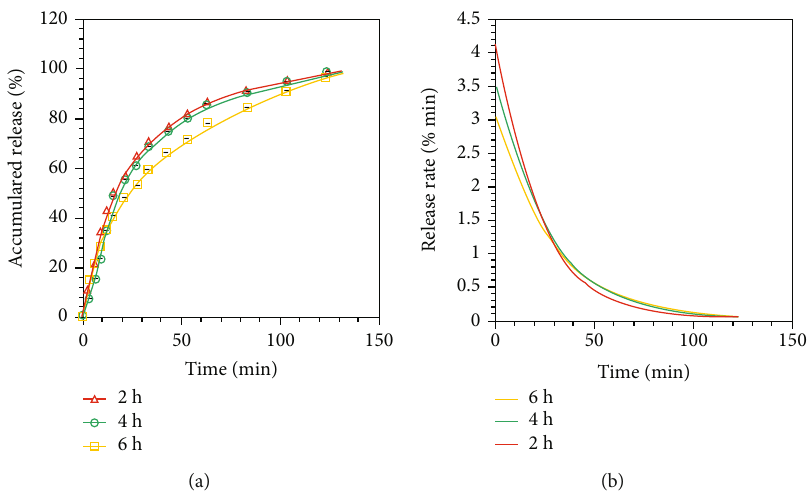
Figure 18: Cumulative release curves (a) and release rate curves (b) of FITC-dextran-loaded chitosan microcapsules with di ff erent thicknesses at room temperature [45].